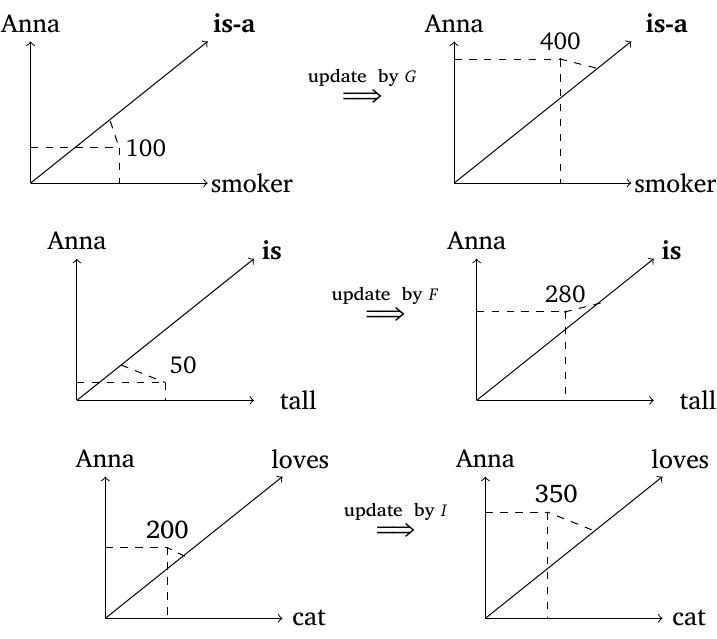
Figure 3: An example of updates